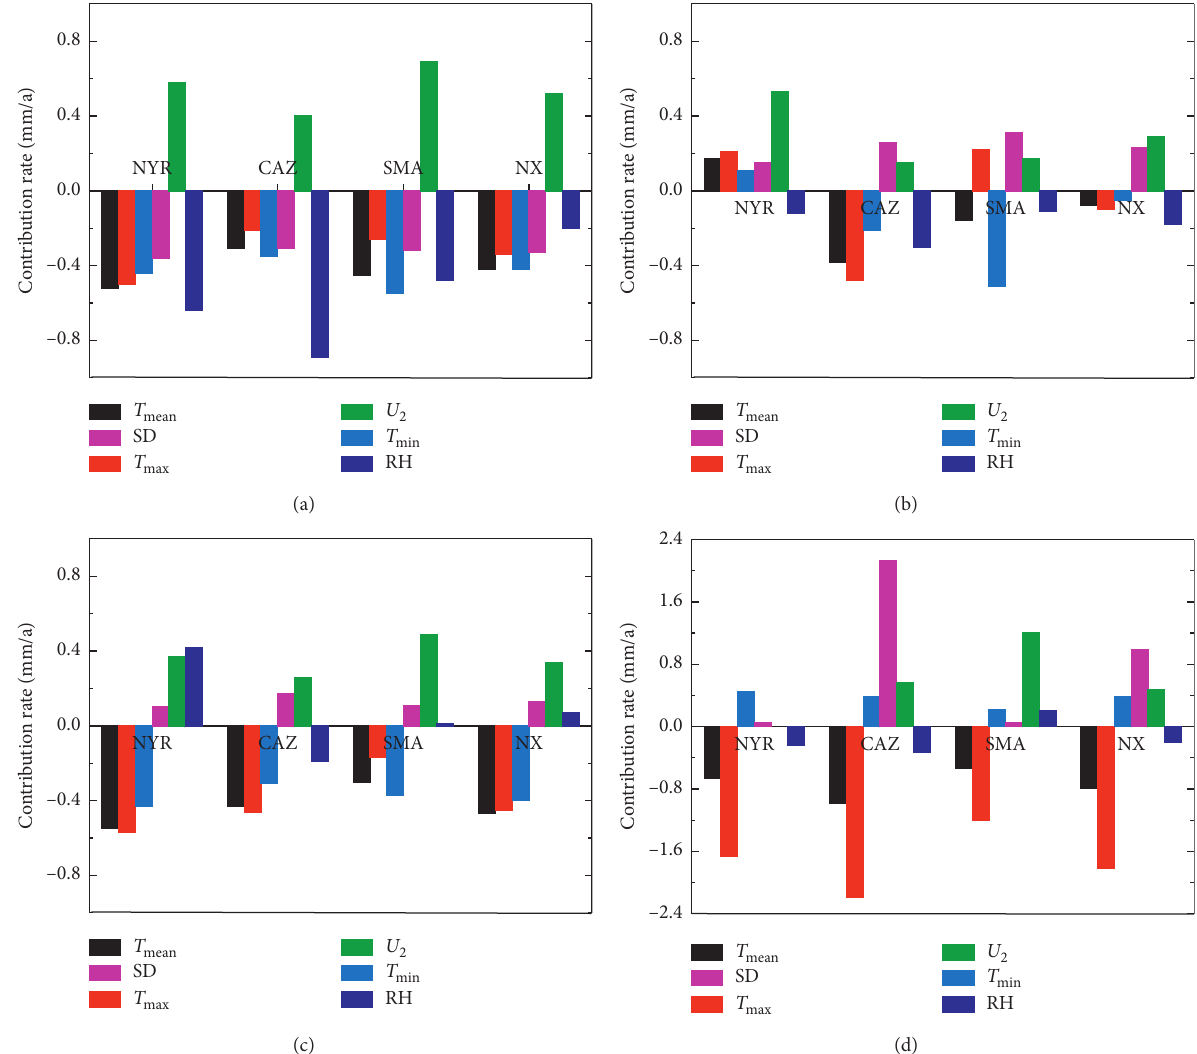
Figure 16: Contribution rate of the main climate factors in Ningxia at seasonal scale (mm/a): (a) spring; (b) summer; (c) autumn; (d) winter.